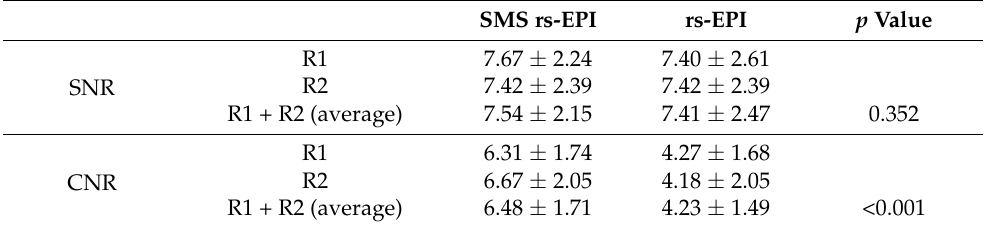
Table 3. Objective image quality assessment of SMS rs-EPI and conventional